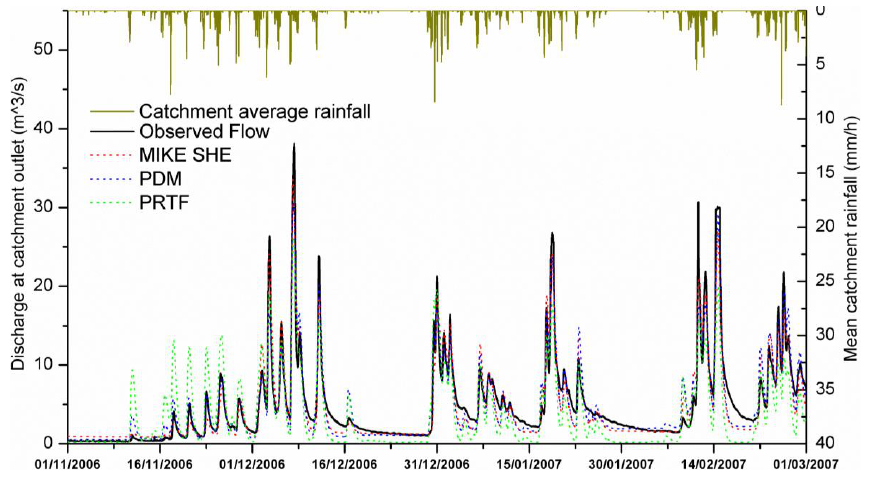
Fig. 3. The results of model validation with raingauge rainfall.